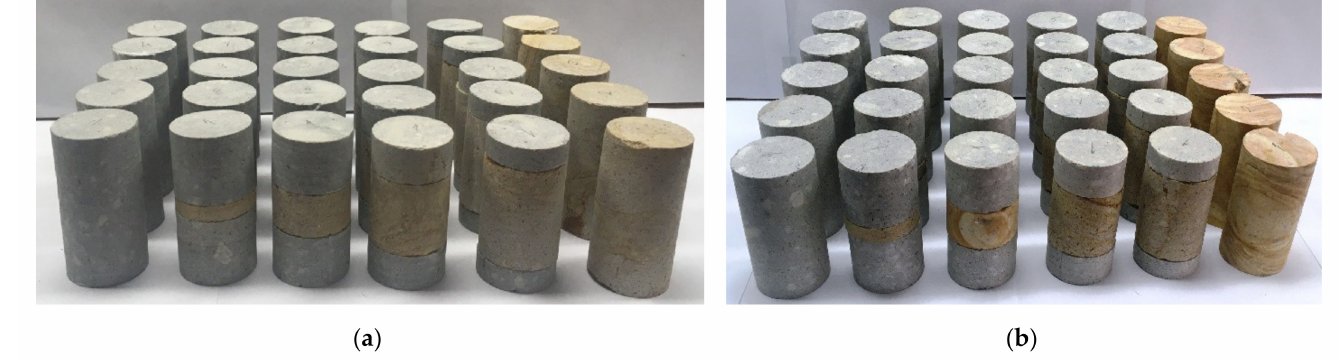
Figure 5. Composite specimens prepared for testing: ( a ) UCS, and ( b ) triaxial